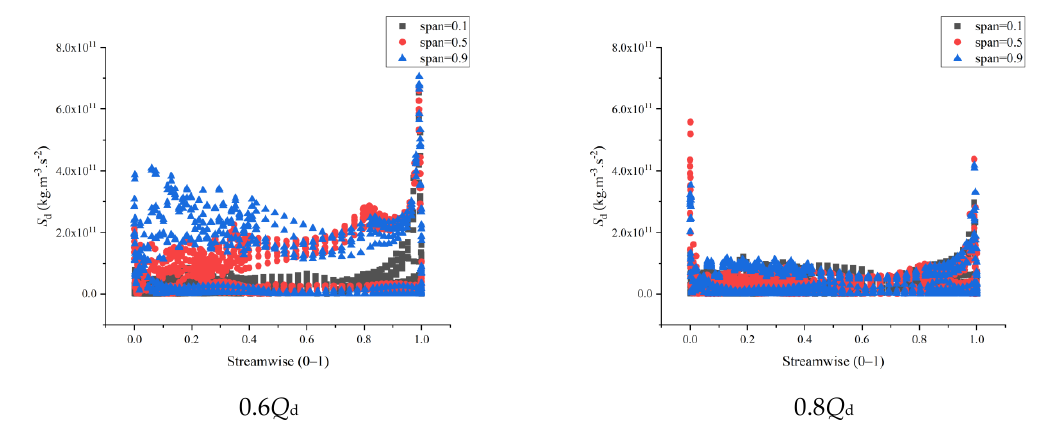
span = 0.9 section, depicting the same pattern at 0.6 Q d , 0.8 Q d , and 1.2 Q d, subsequently.